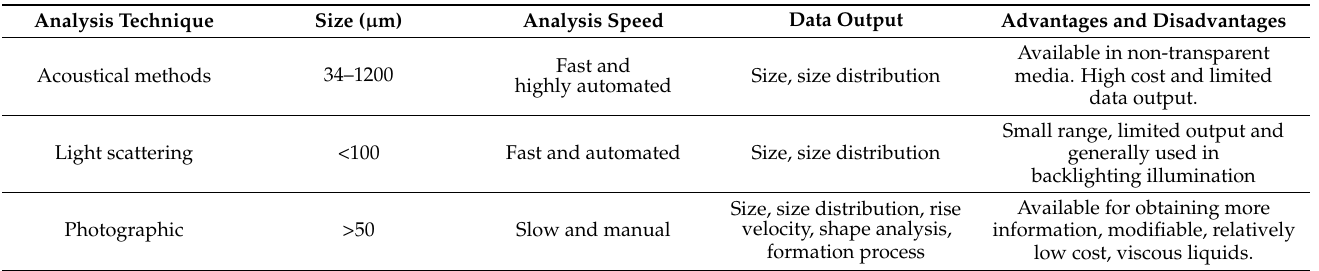
Table 1. Comparison of three major techniques to measure the size of